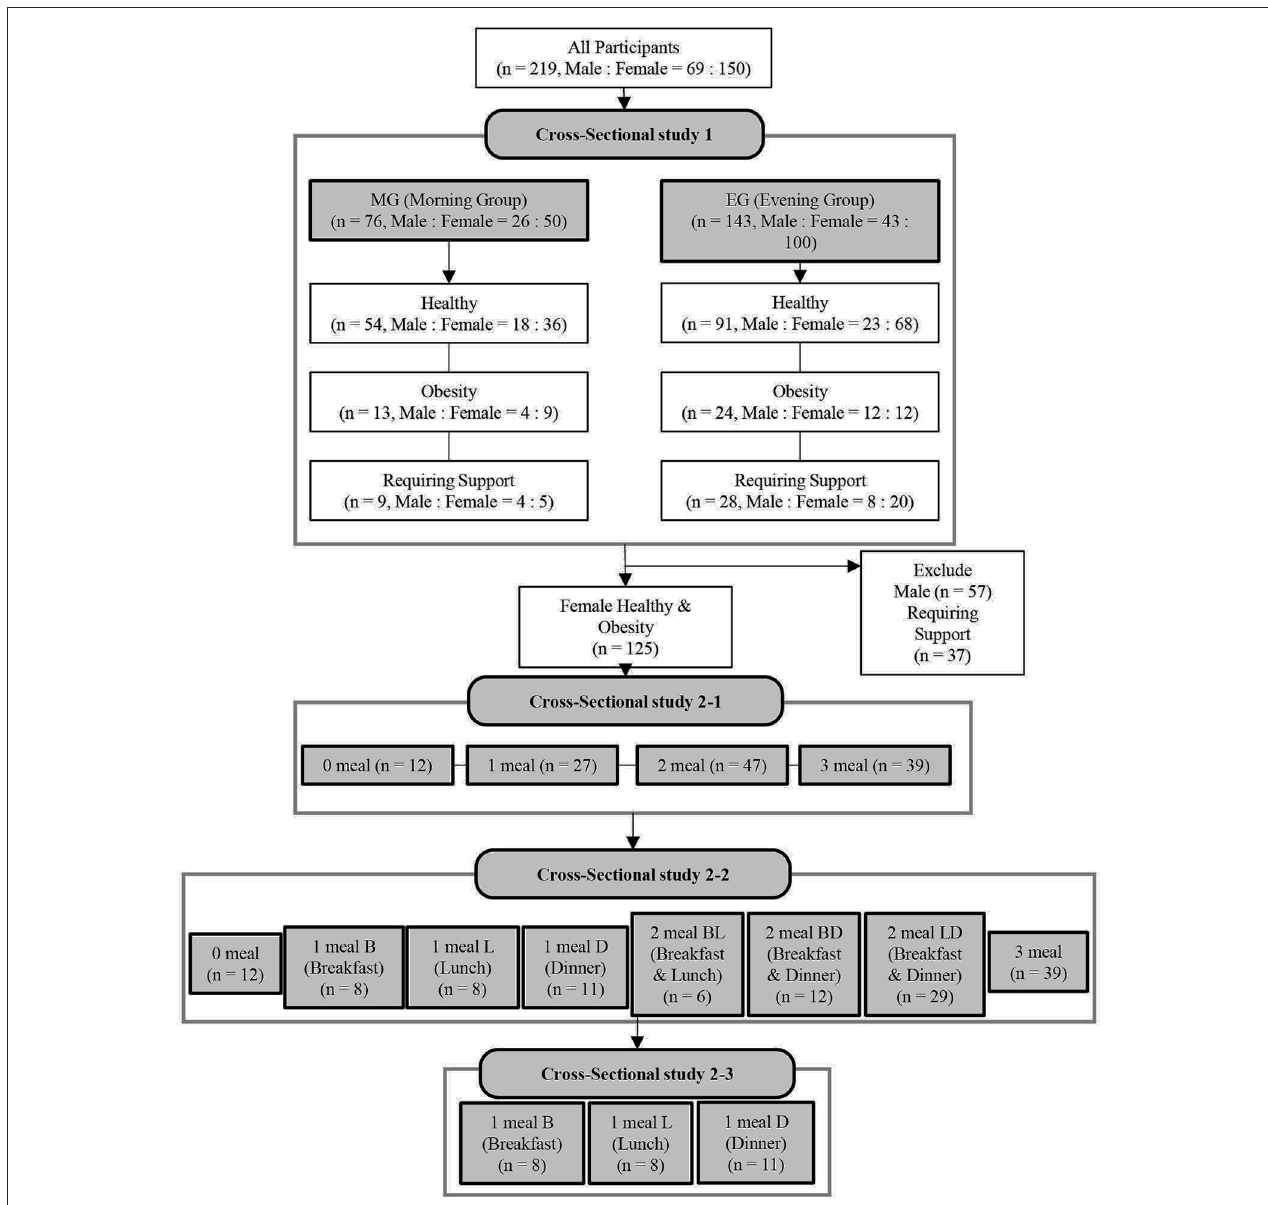
FIGURE 1 | Flow diagram showing the design of the cross-sectional study. B, breakfast; L, lunch; D, dinner.